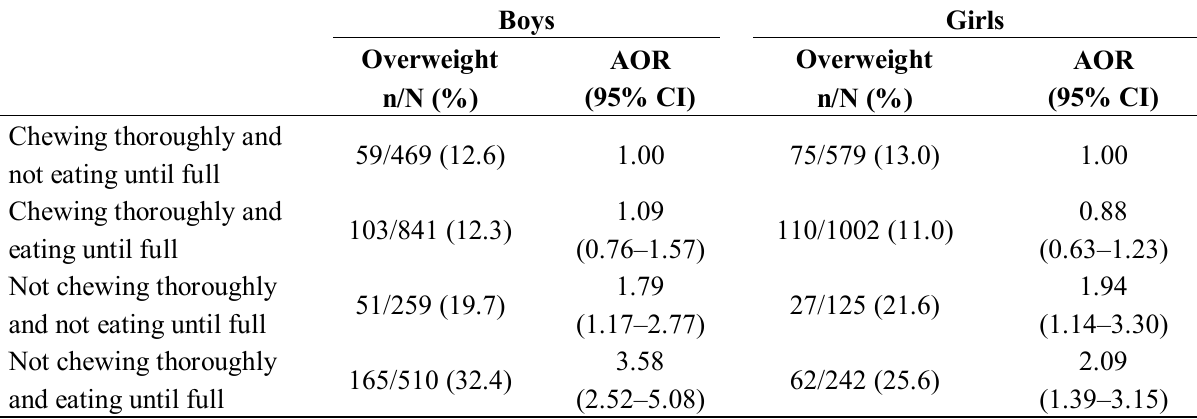
Table 5. Adjusted odds ratios of combinations of chewing thoroughly and eating until full for being